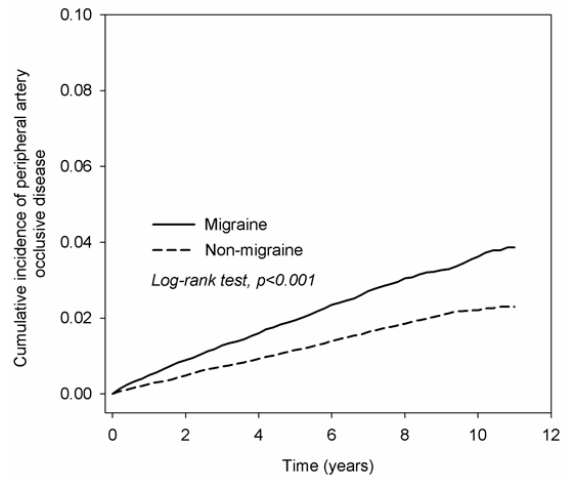
Figure 2. The Kaplan–Meier curves with a cumulative incidence of peripheral artery occlusive disease between the study and control groups.